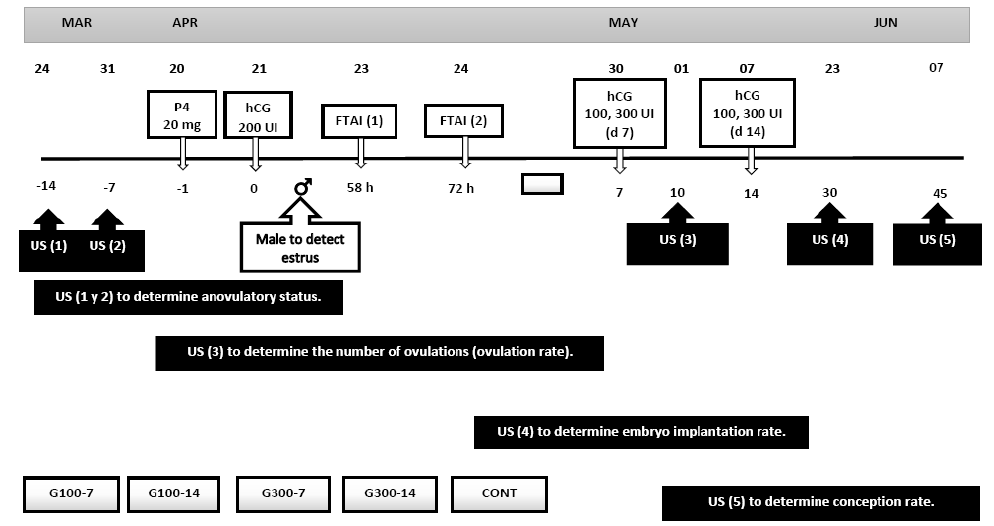
Figure 1. Schematic representation of the experimental protocol. The application of hCG (100 and 300 UI) was on day 7 and 14 post-FTAI. Ultrasound (US) was performed to determine anovulatory status, the number of ovulations (ovulation rate), the embryo implantation rate, and conception rate.